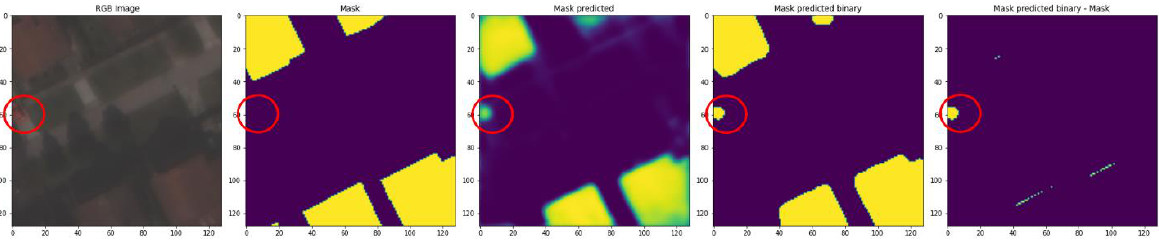
Figure 18. A car identified as a building.